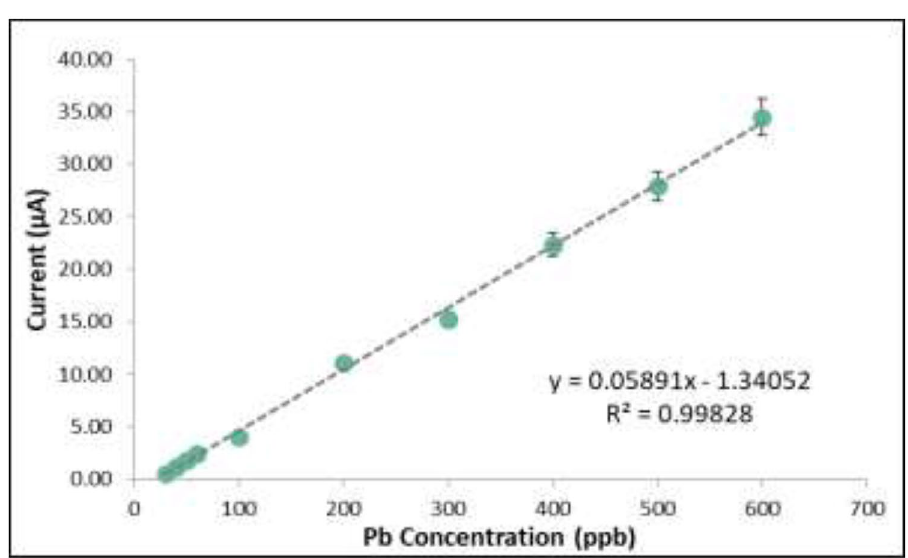
Figure 11. Calibration curve of the modified